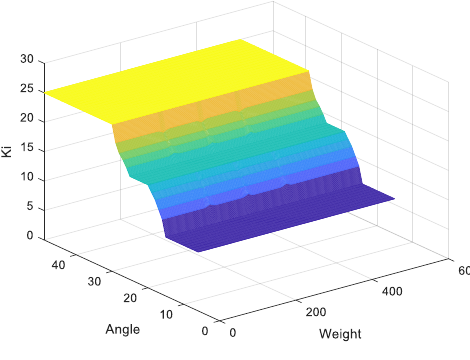
Figure 18. Output of Kp.